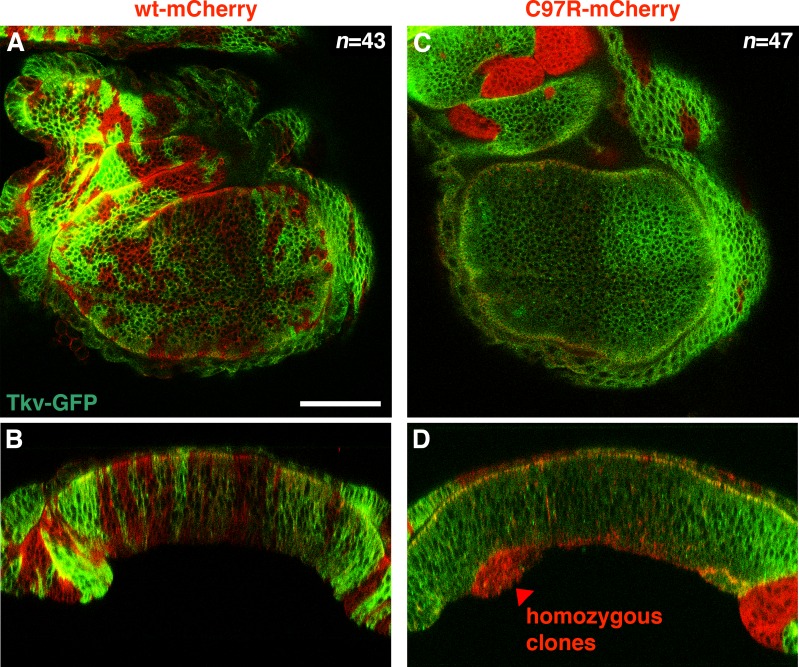
Basal extrusion of tkvC97R homozygous mutant clones from the wing epithelia.(A–D) tkvC97R homozygous mutant clones were basally eliminated from wing epithelia. (A, B) To generate mCherry-labelled wild-type control clones, hs-flp; tkvGFP>>mCherry/tkvmCherry animals were heat shocked for 10 min at 72 hr AEL. (C, D) Homozygous mCherry-labeled tkvC97R clones were generated with an identical heat shock regimen in larvae of the genotype: hs-flp; tkvGFP>>C97R-mCherry/tkvCC97R-mCherry. The upper and lower panels show standard XY and optical cross section XZ images of each wing disc, respectively. Arrowhead (red) indicates eliminated tkvC97R homozygous mutant cells. Scale bars: 50 μm. Anterior is left.